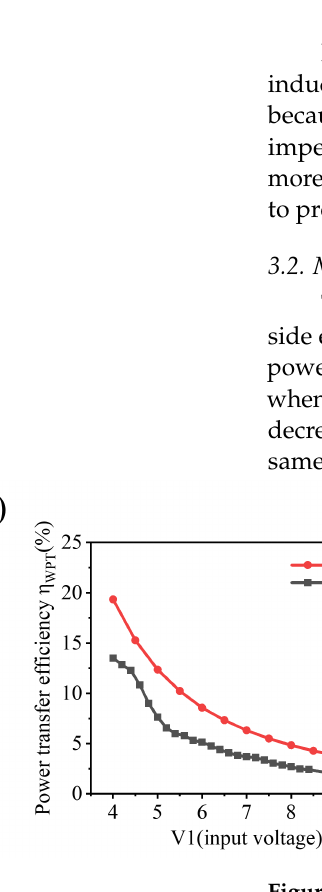
Figure 9. Measurement results of the linear-power-regulated WPT system. ( a ) The power efficiency of the overall WPT system, ( b ) the power efficiency of the secondary side, ( c ) the analysis of the secondary side power